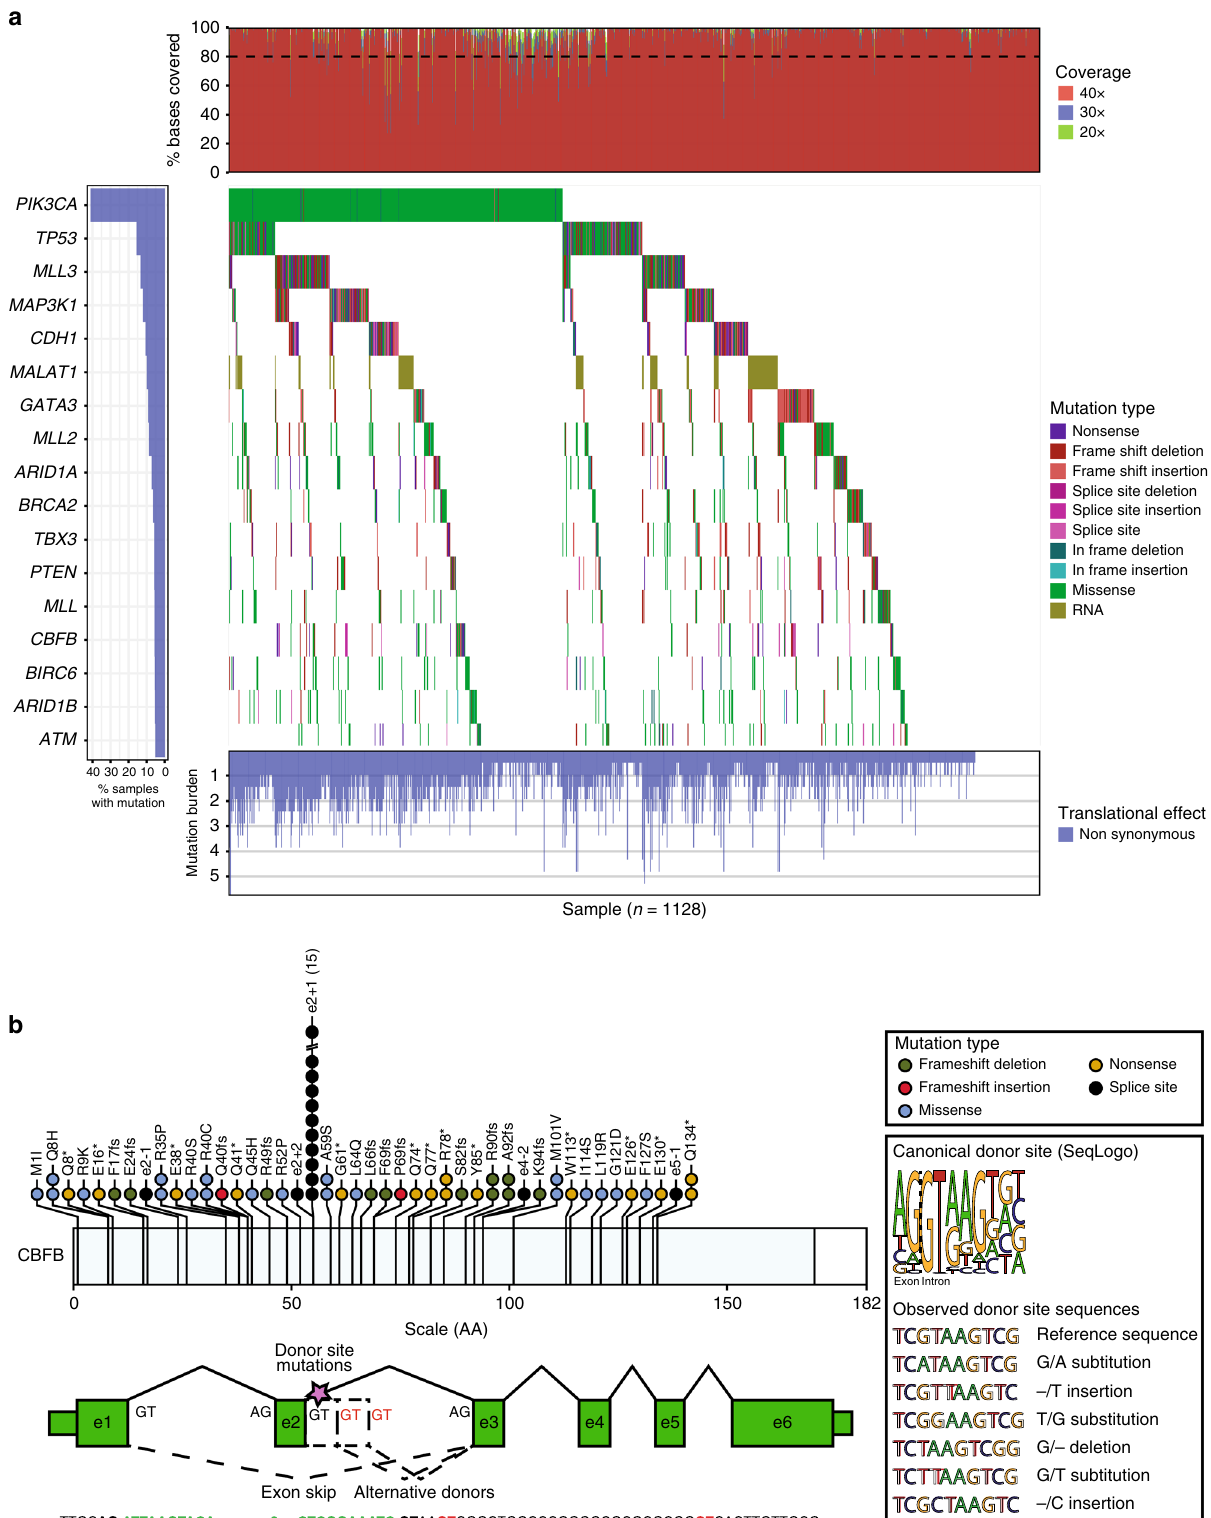
ATMARID1BBIRC6CBFBMLLPTENTBX3BRCA2ARID1AMLL2GATA3MALAT1CDH1MAP3K1MLL3TP53PIK3CA 010203040 % samples with poor outcome in univariate analysis as displayed in Fig. 4b.